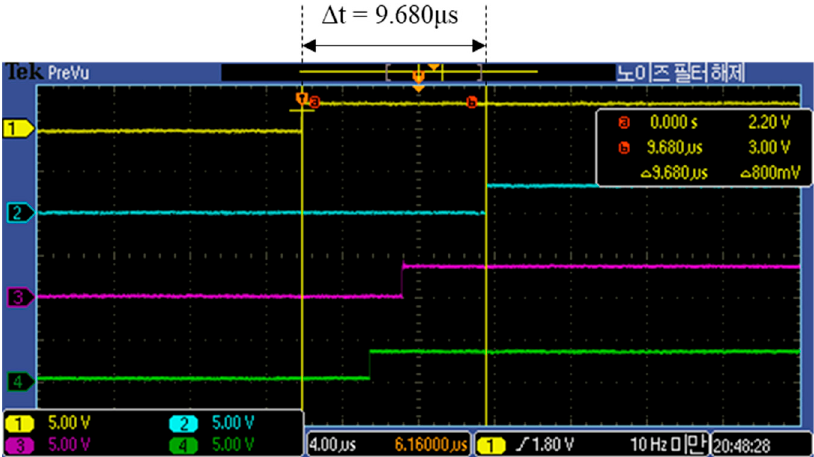
Figure 8. Evaluation results of the synchronization in the CAN–Ethernet network.